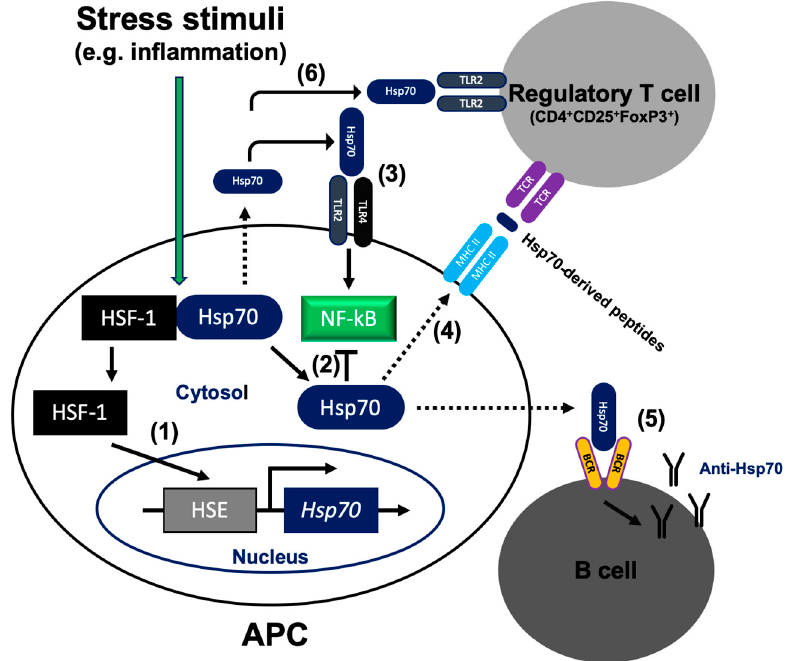
Figure 1. Mode of 70-kDa heat shock protein (Hsp70) action inside and outside the cell. (1) During unstressed conditions, heat shock factor (HSF)1 exists as a monomer in complex with cytoplasmic Hsp70. Upon cellular stress (e.g., inflammation), HSF1 accumulates in the nucleus and binds to the heat shock element (HSE) that is found in the upstream regulatory regions of the Hsp70 gene. (2) Intracellular Hsp70 blocks NF- κ B activation. (3) Acting as damage-associated molecular pattern (DAMP), extracellular Hsp70 interacts with TLR2 / 4 and activates the inflammatory pathway via NF- κ B in antigen presenting cells (APC). (4) Extracellular Hsp70 leads to Treg expansion. Hsp70-derived peptides are delivered to the major histocompatibility complex (MHC) class II molecules and presented on the cell surface for recognition by Treg. (5) Extracellular Hsp70 stimulates the humoral autoimmune response and production of the anti-Hsp70 autoantibodies. (6) Extracellular Hsp70 enhances immunosuppressive function of Treg cells via the TLR2 signaling pathway. Dotted lines illustrate translocation of Hsp70 across the cell membrane.